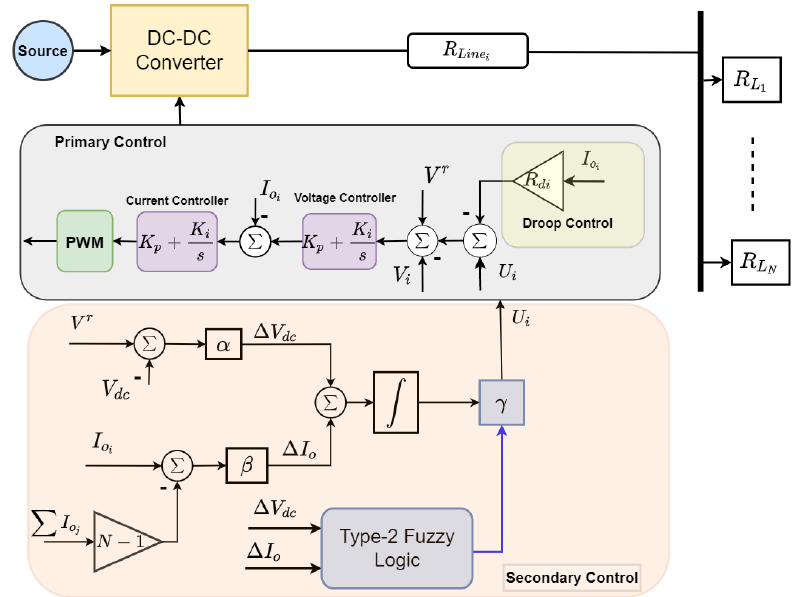
Figure 3. Proposed fuzzy-based distributed secondary control